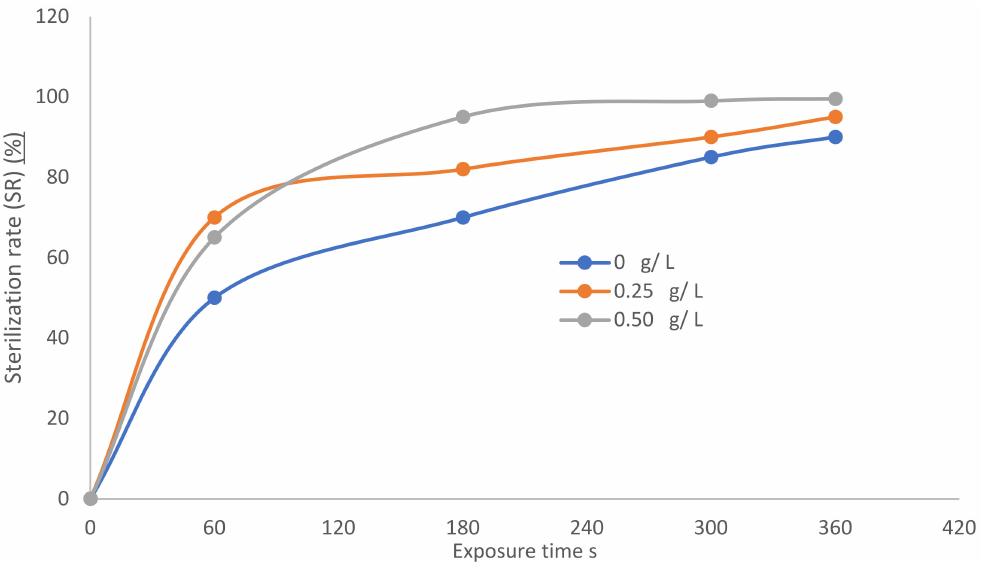
Figure 9. Sterilization rate (SR) (%) versus exposure